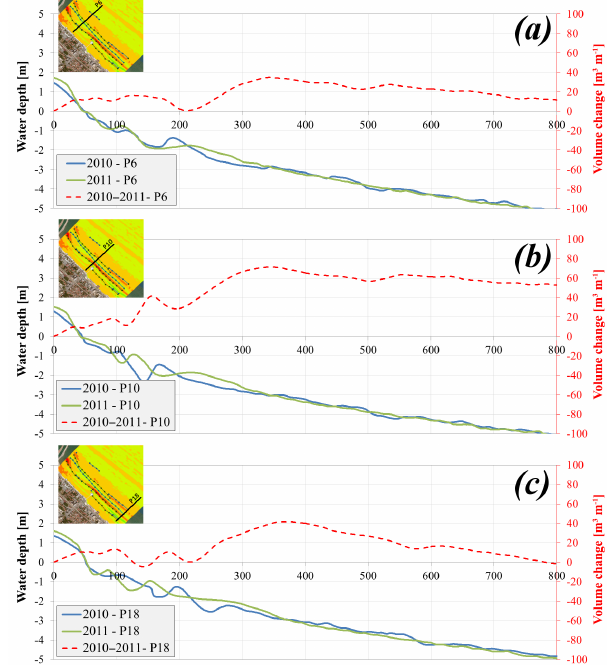
Figure 6. Cross-shore profiles collected in 2010 (solid blue lines) and 2011 (solid green lines), and cumulative volume variations in 2010–2011 (dashed red lines). The represented sections refer to (a) the northern region, i.e., between the jetty and the Rotonda, (b) the middle region, i.e., close to the Rotonda, and (c) the southern